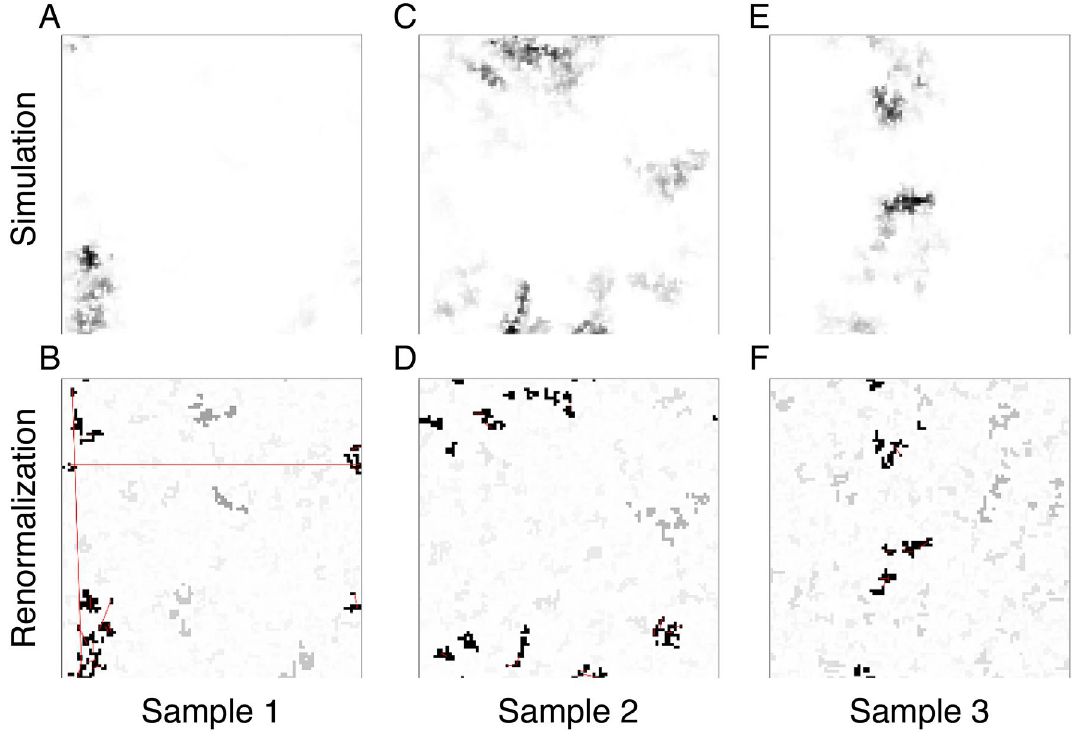
Figure 6. Results in 2D with long-range interactions. Here we show our results for algebraically decaying interaction probability with an exponent s = 4 , for N = 100 × 100 sites with periodic boundary conditions. The number of short-cuts is N /16 and the strength of disorder is α = 4 . Red links indicate long-range connections within the main cluster. The critical clusters are even more strongly disconnected objects, with a formally zero fractal dimension 29